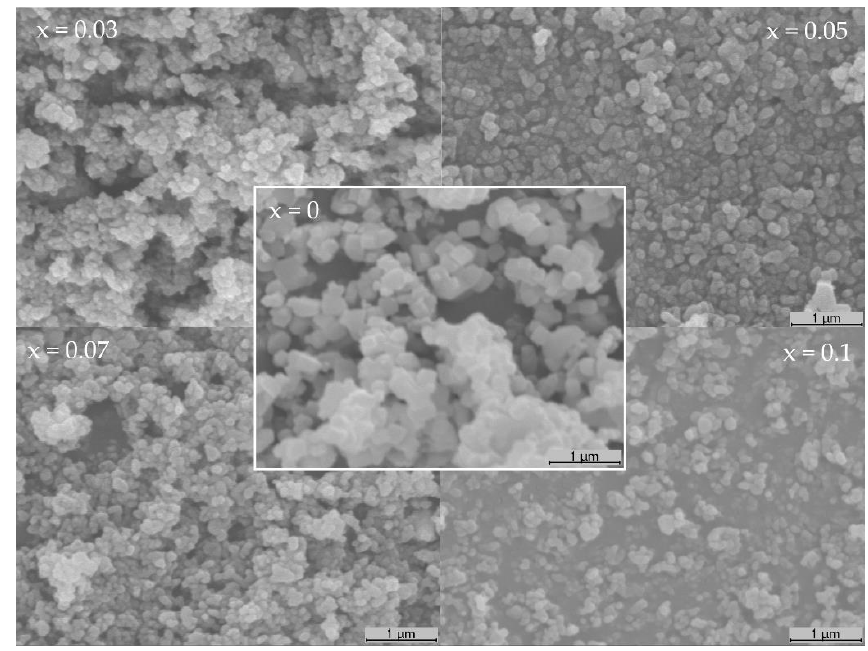
Figure 2. SEM micrographs of the Sr 1-x Bi x TiO 3 powder samples (×20,000).